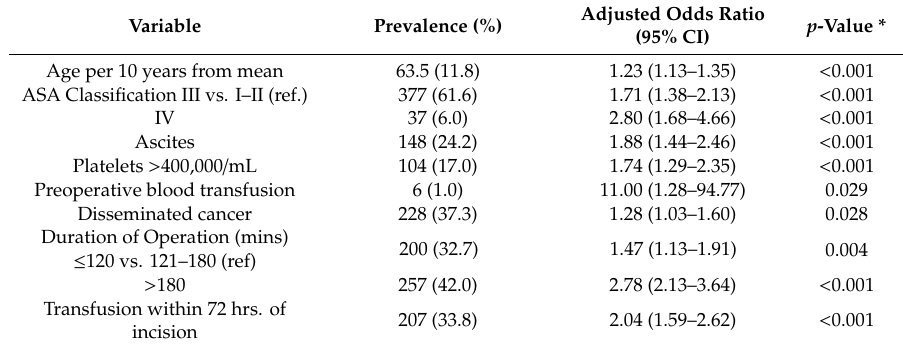
Table 2. Multivariable predictors of prolonged LOS in patients undergoing hysterectomy for ovarian cancer (Hosmer-Lemeshow (H-L) statistic p = 0.398, c-index =